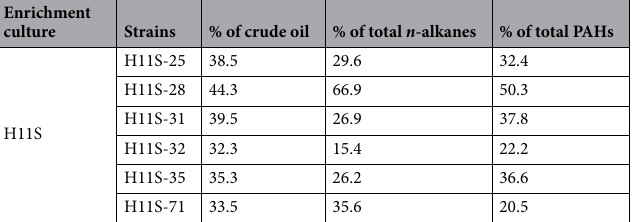
Enrichment culture